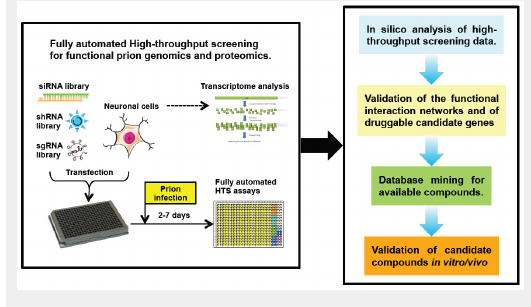
Proposed new strategies for high throughput small RNA screens to discover cell signalling mechanisms and novel therapeutic target for prion disease. HTS = high throughput screening; sgRNA = single guide RNA; shRNA = short hairpin RNA; siRNA = small interfering